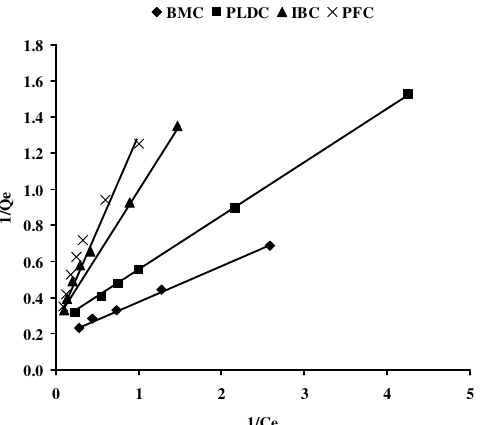
Figure 1 . Freundlich isotherm for the removal of Mn(II) at various concentrations of Mn(II) solution.